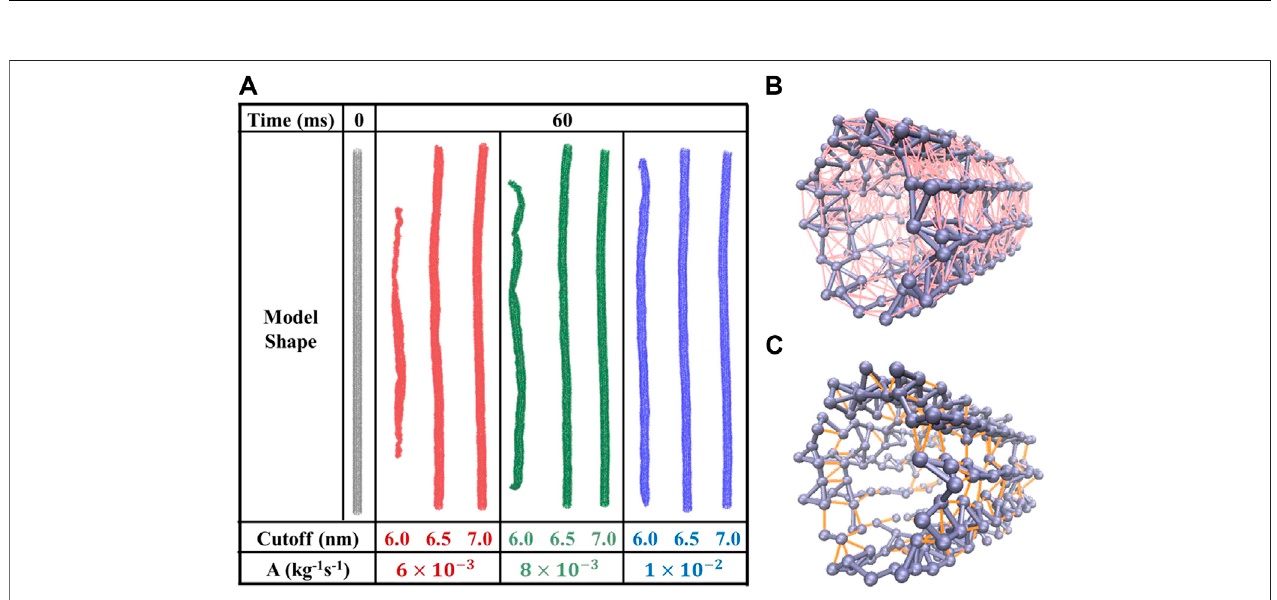
FIGURE 4 | (A) An illustration of the minimal number of UCG beads required for maintaining the grooves of microtubule. (B) The transverse and longitude views of the built models. (C) Zoomed top and side views of the density map of 8 adjacent tubulins, labeled with the upper cases A-H. The different colors denote the density regions which are clustered into the UCG beads, with the corresponding UCG bead centers shown.